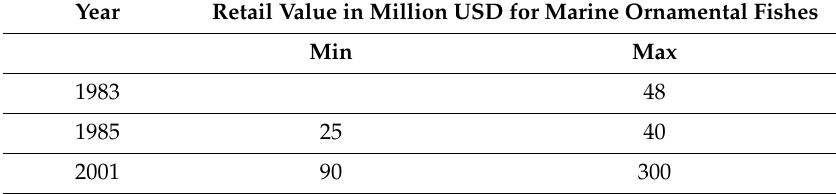
Table 2. Estimated retail value (USD) for marine ornamental fishes from 1983 to 2001 [1,37,55]. Year Retail Value in Million USD for Marine Ornamental Fishes